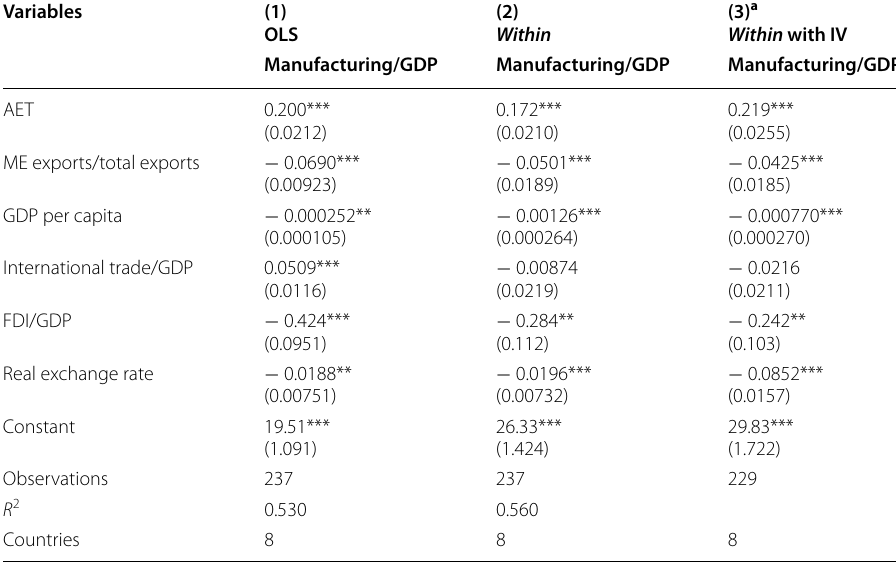
Standard errors in